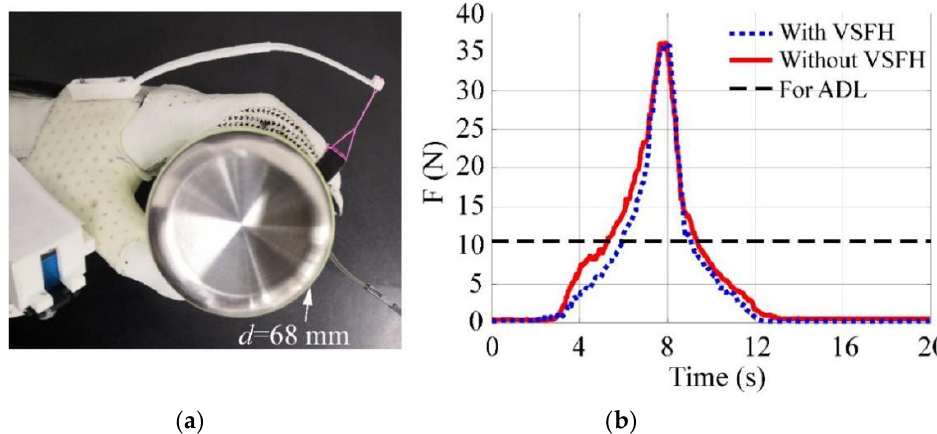
Figure 12. Measurement ( a ) and results ( b ) of the index fingertip force when grasping a cylinder with a diameter of 68 mm.